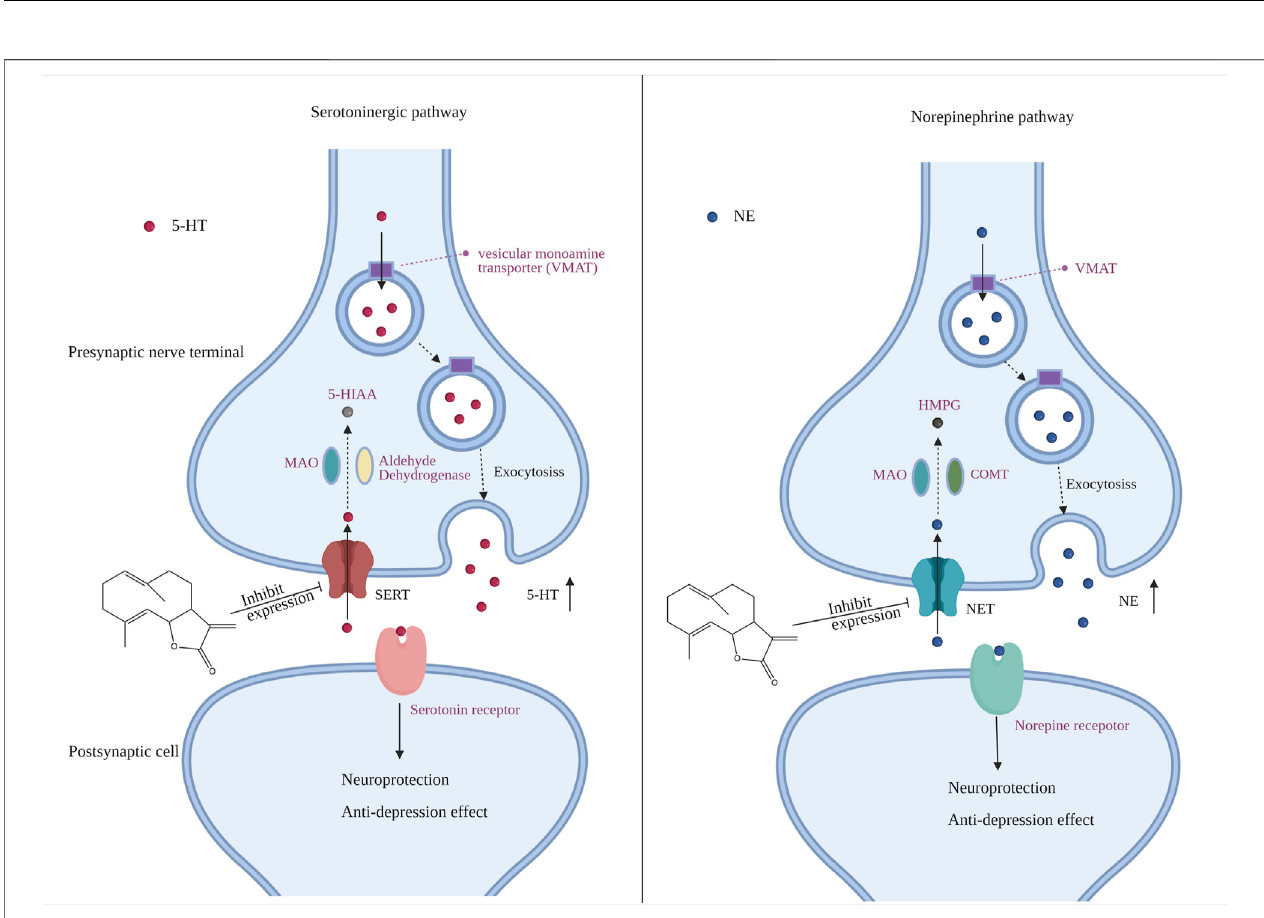
Frontiers in Pharmacology |